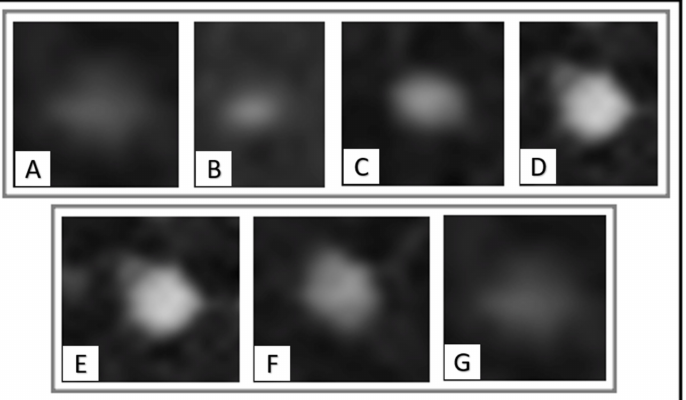
Figure 1. Examples of lung nodule contrast categorization (( A ): very low contrast; ( B ): low contrast; ( C ): moderate contrast; ( D ): high contrast) and density categorization (( E ): solid; ( F ): part-solid; ( G ): pure ground glass) at CT.